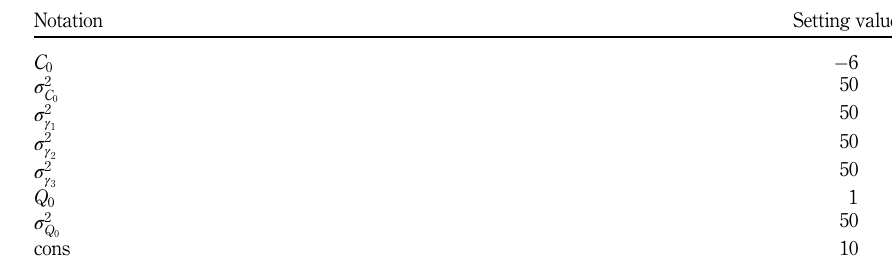
Table I. Setting value of the pooled parameters